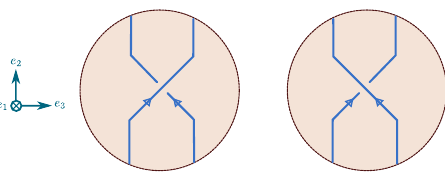
Figure 27 . Standard forms for the projection of the link L to the x 2 - x 3 plane, restricted to a domain R × D . Left: overcrossing. Right: undercrossing. c